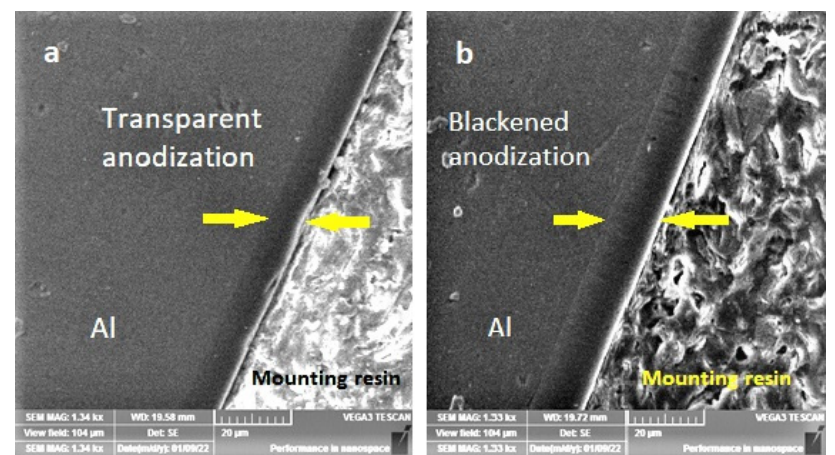
Figure 5. SEM images of ( a ) the transparent anodization layer and ( b ) the blackened anodization layer of commercial